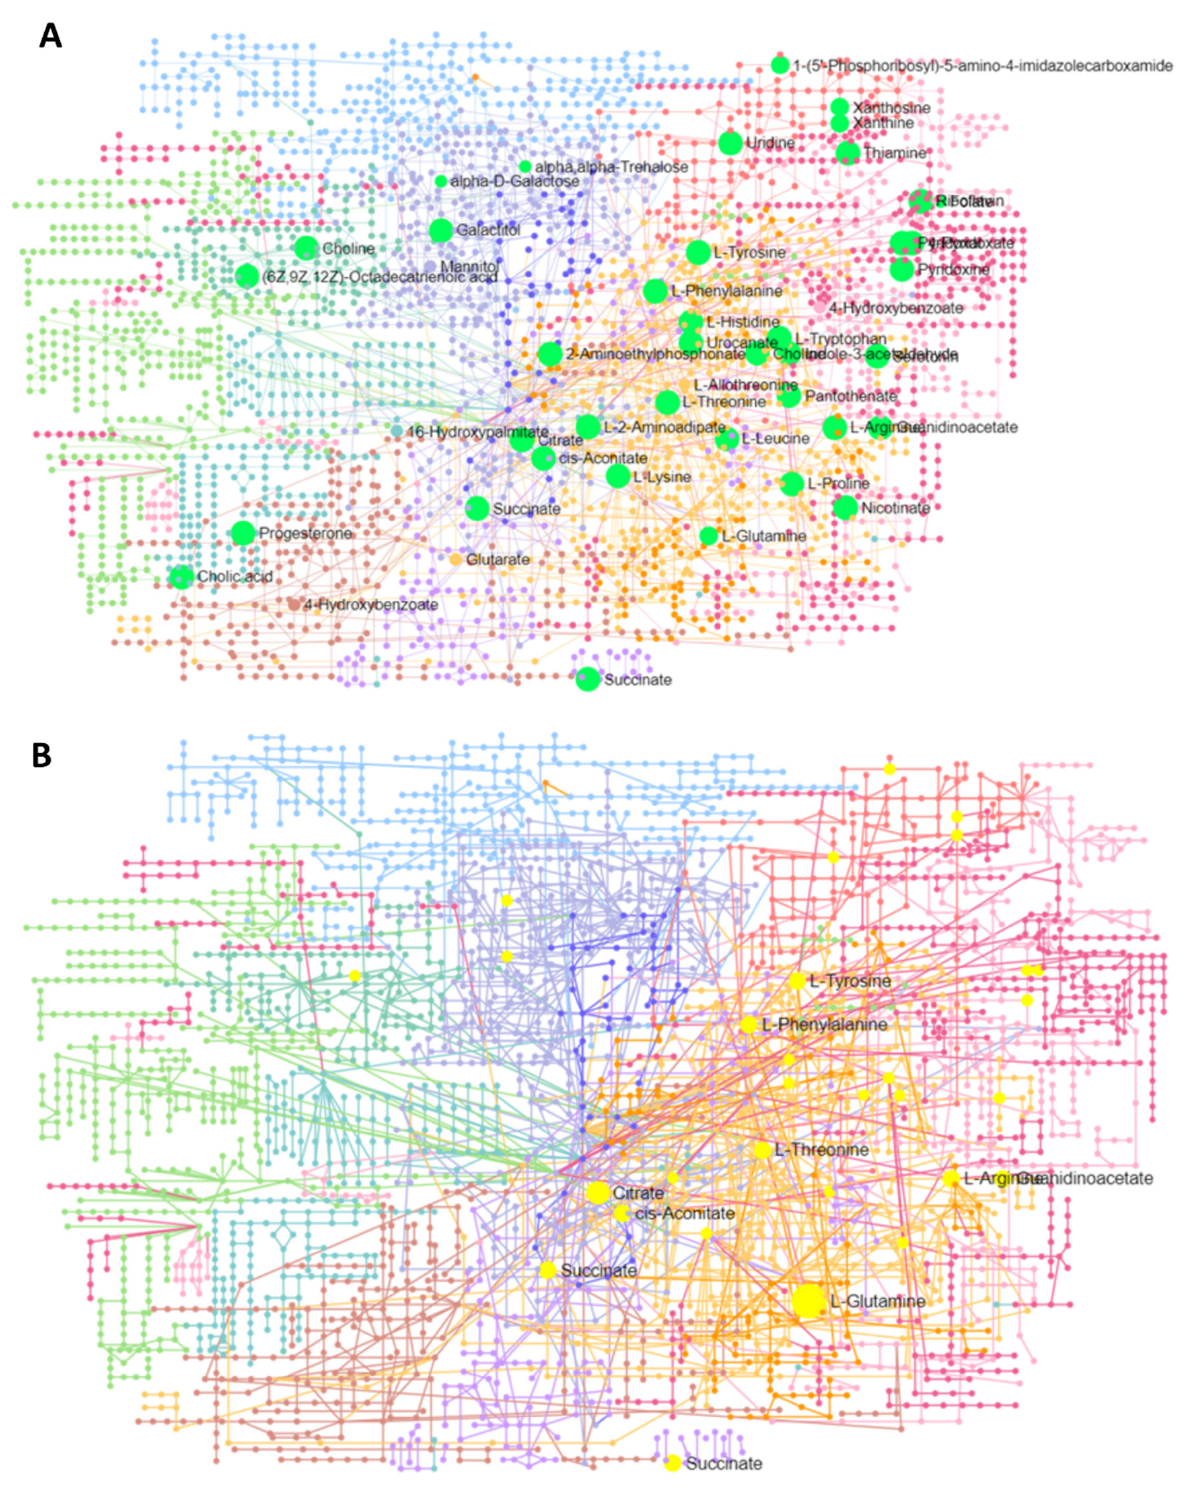
Figure 6. A network analysis of pathways carried out using an integrated analysis of all pathways (using transcriptome and metabolome data input); ( A ) presents the comprehensive network of integrated pathways, where all mapped queries of metabolites (highlighted in light green) are involved in pathways with more than one hit are labeled. Similarly, ( B ) shows the same network, with metabolite nodes involved in multiple pathways (highlighted in yellow) with more than one hit being labeled.